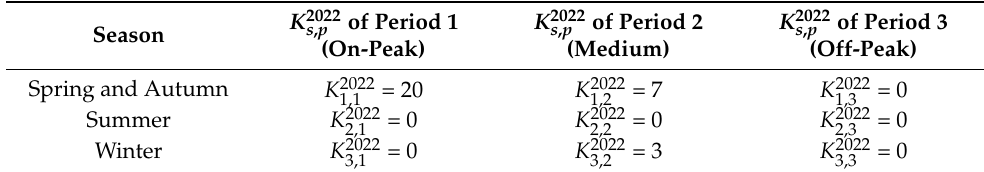
Table 9. Analysis results of the number of VRE curtailment K 2022 s , p in Jeju 2022.